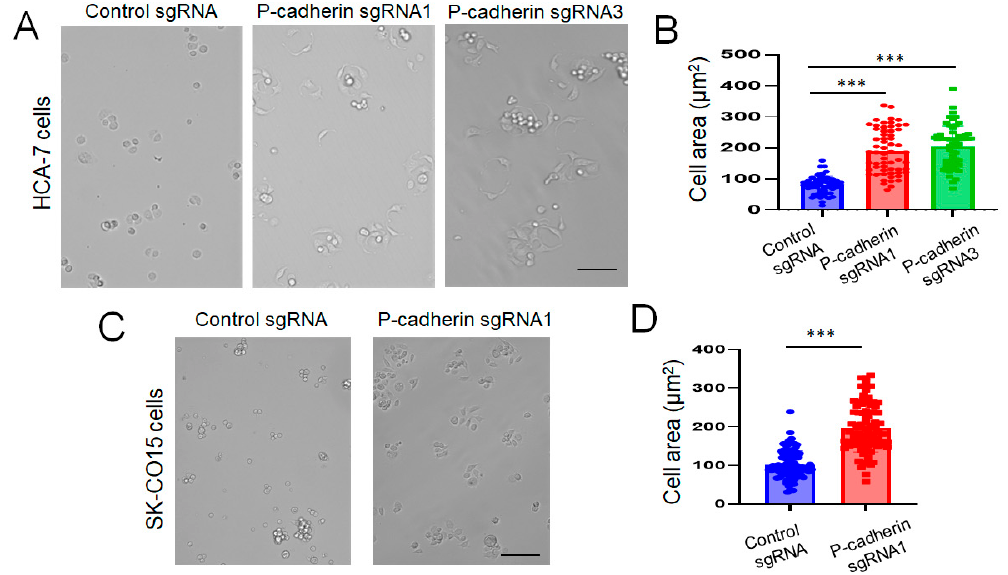
Figure 6. Loss of P-cadherin expression promotes intestinal epithelial cell spreading. Control and P-cadherin-depleted HCA-7 ( A , B ) and SK-CO15 ( C , D ) cells were plated on collagen I coated plates, allowed to spread for 1 h and imaged using bright field microscopy. Representative images of spread cells ( A , C ) and quantification of the cell area ( B , D ) are shown. Means ± SE ( n = 60 and 90 for HCA-7 and SK-CO15 cells, respectively); *** p < 0.005. Scale bars, 100 µ m. The results shown are representative of two independent experiments.